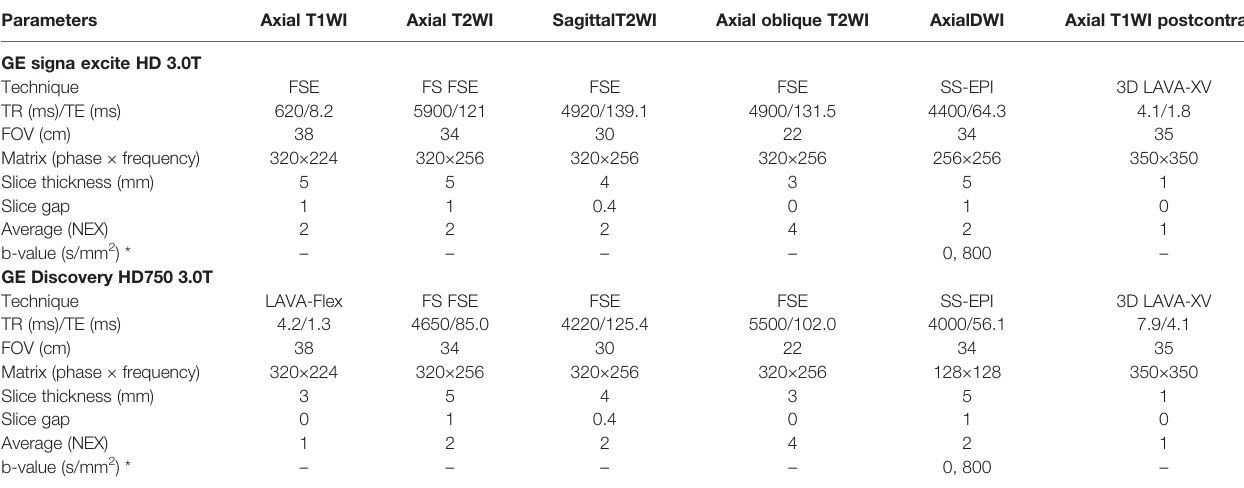
TABLE 1 | Detailed Sequences Scanning Parameters in Two MR Scanners.